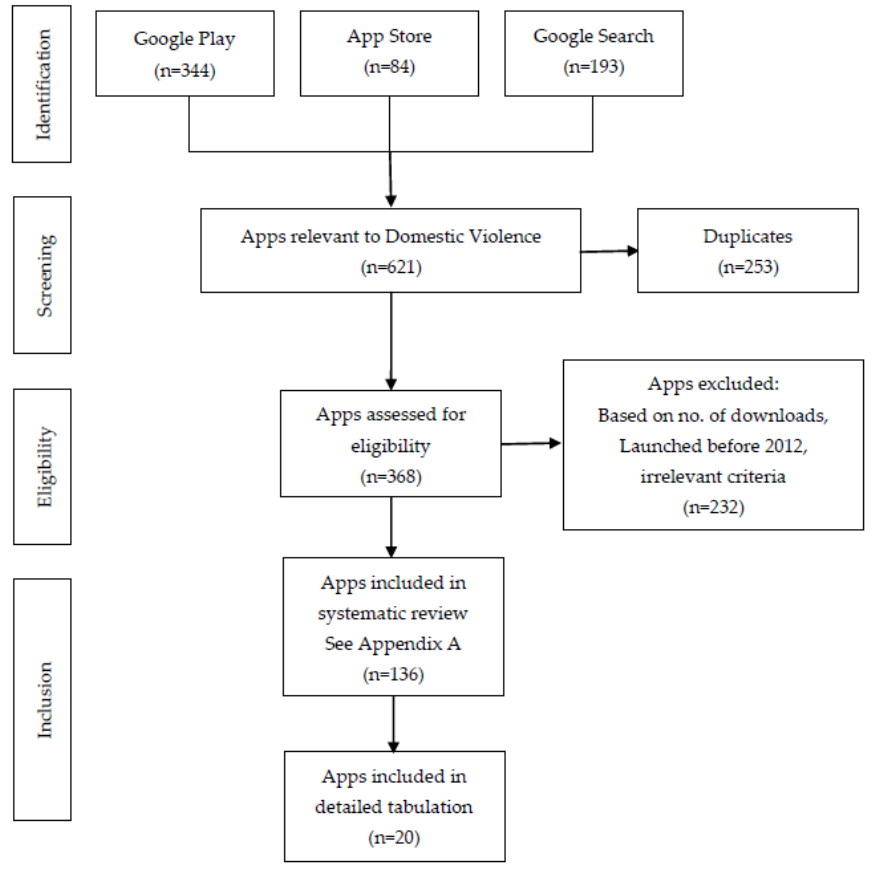
Figure 1. Flow diagram of the systematic review.